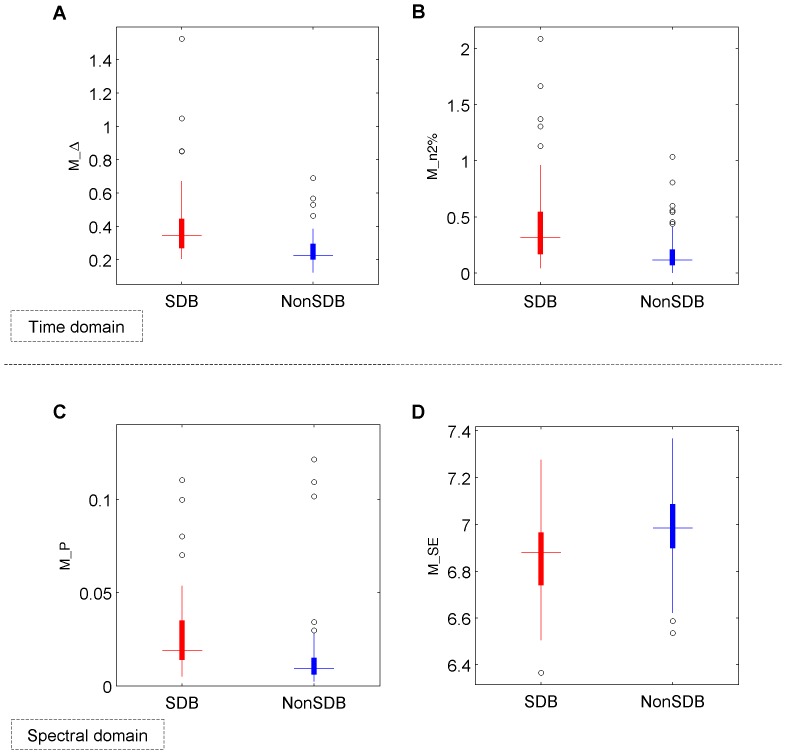
Distribution of SpO2 pattern characterization features.Boxplot of some features extracted from SpO2 pattern characterization such as (A) the mean of Δ (M_Δ), (B) the number of desaturations of 2% below baseline (M_n2%), (C) the spectral power in the modulation band (M_P), and (D) the spectral Shannon entropy (M_SE). Children with SDB show higher SpO2 variability reflected M_Δ and a higher number of desaturations M_n2% due to sleep apnea. They also reflect higher power in the modulation band and lower spectral complexity (see Table 3). Quartile values are displayed as bottom, middle and top horizontal line of the boxes. Whiskers are used to represent the most extreme values within 1.5 times the interquartile range from the median. Outliers (data with values beyond the ends of the whiskers) are displayed as circles.